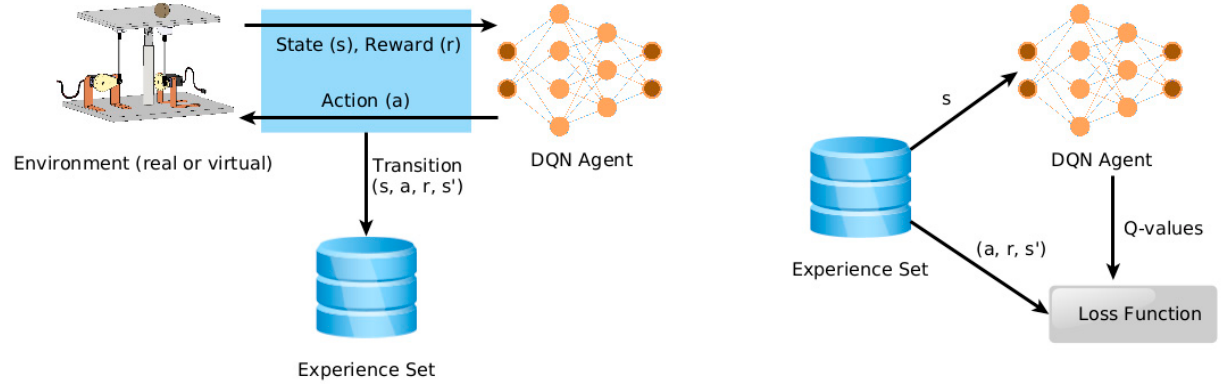
Figure 9. State-transition experiences are collected during trials ( left ). These experiences are then used to train the agent ( right ).